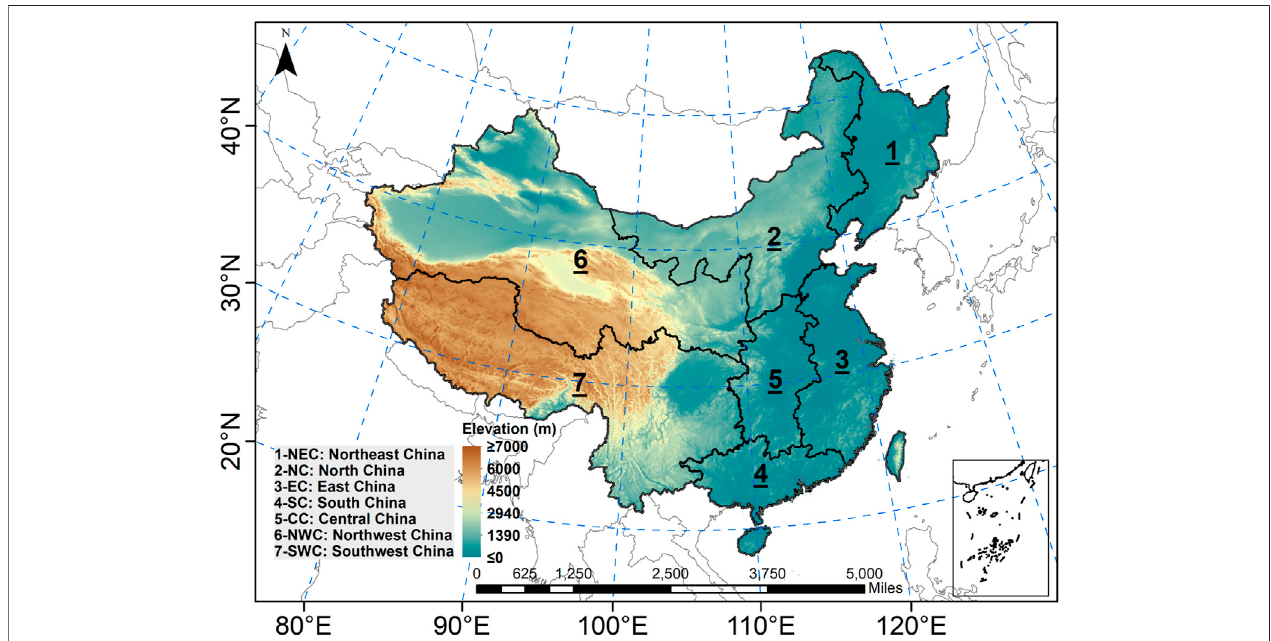
FIGURE 1 | The study area of China with seven sub-regions. The seven sub-regions are Northeast China, North China, East China, South China, Central China, Northwest China, and Southwest China.